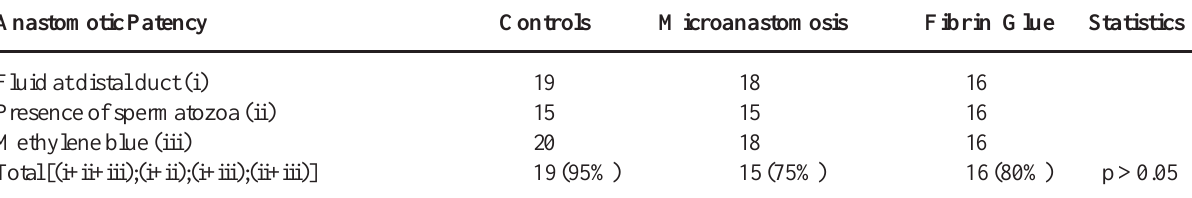
Table 4 – Anastomotic patency after 45 days vasovasostomy.